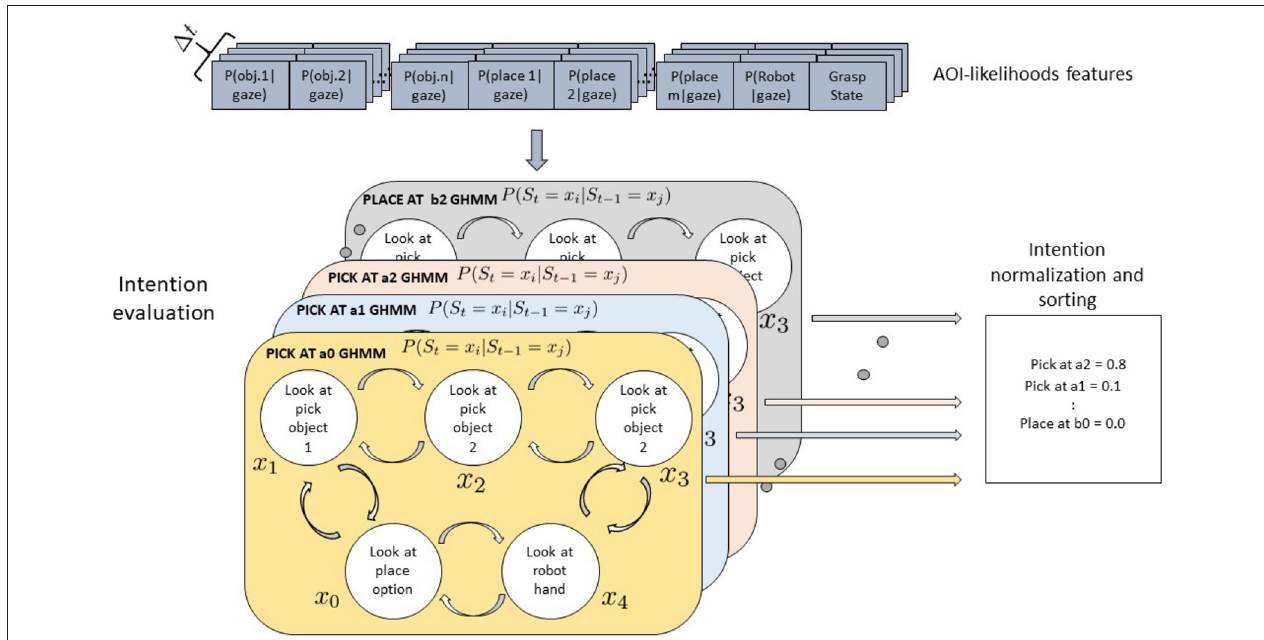
FIGURE 8 | Gaussian Hidden Markov Models for a Pick-and-Place-Task. Five hidden states X are shown which might represent the perceptual state of the user looking at the object to be picked, at the robot, at the placing position target, or at the teleoperated robotic hand. Arrows between states represent transition probabilities: for the sake of legibility here only transitions between adjacent states are shown but actually all states are fully connected. A model is defined for each pick-object and place-at-location intention. Each model receives as input a sequence of vectors of AoI likelihoods, representing the probability of the object under the gaze distribution at different time steps. The emissions probabilities defining the probability of each state to emit the observed features are learned from the data and assumed Gaussian. Each model outputs a likelihood of the corresponding intention after observing the current sequence of features.